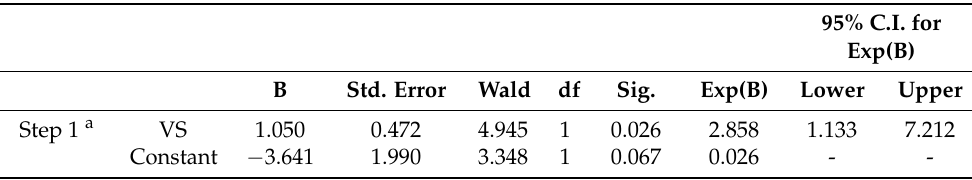
Table 29. Vendor support: regression analysis for